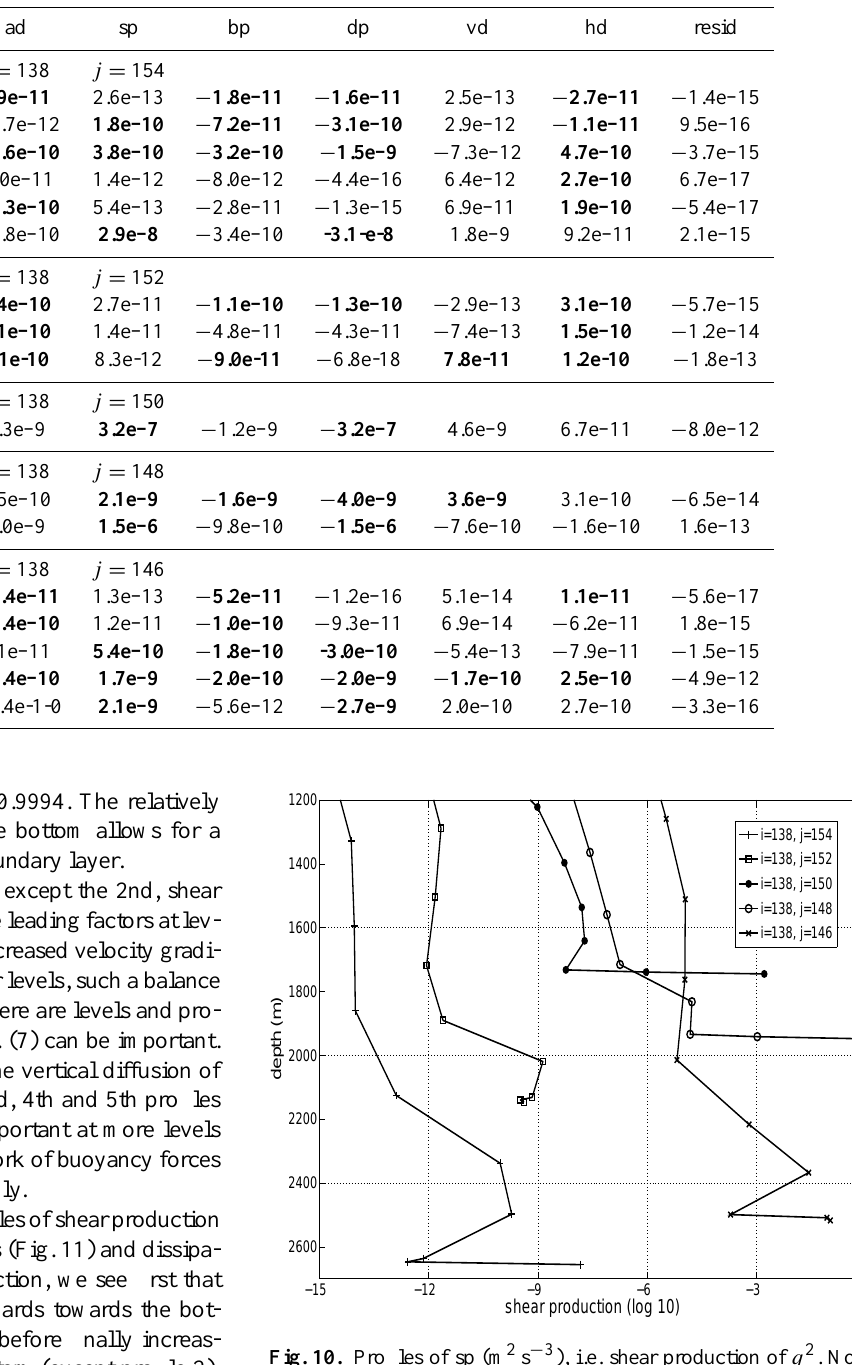
Table 1. Near bottom values of different terms of the q 2 Eq. (7) at 5 points (location indices are given) across the Lifamatola Sill as follows: rate of time difference (td), 3-D advection (ad), shear production (sp), work of buoyancy forces (bp), dissipation (dp), vertical diffusion (vd), and horizontal diffusion (hd) and the difference between the left-hand side and right-hand side of Eq. (7) (resid), where resid=td+ad-(vd + sp + bp + dp + hd). Leading terms are indicated by bold. All units in m 2 s − 3 .